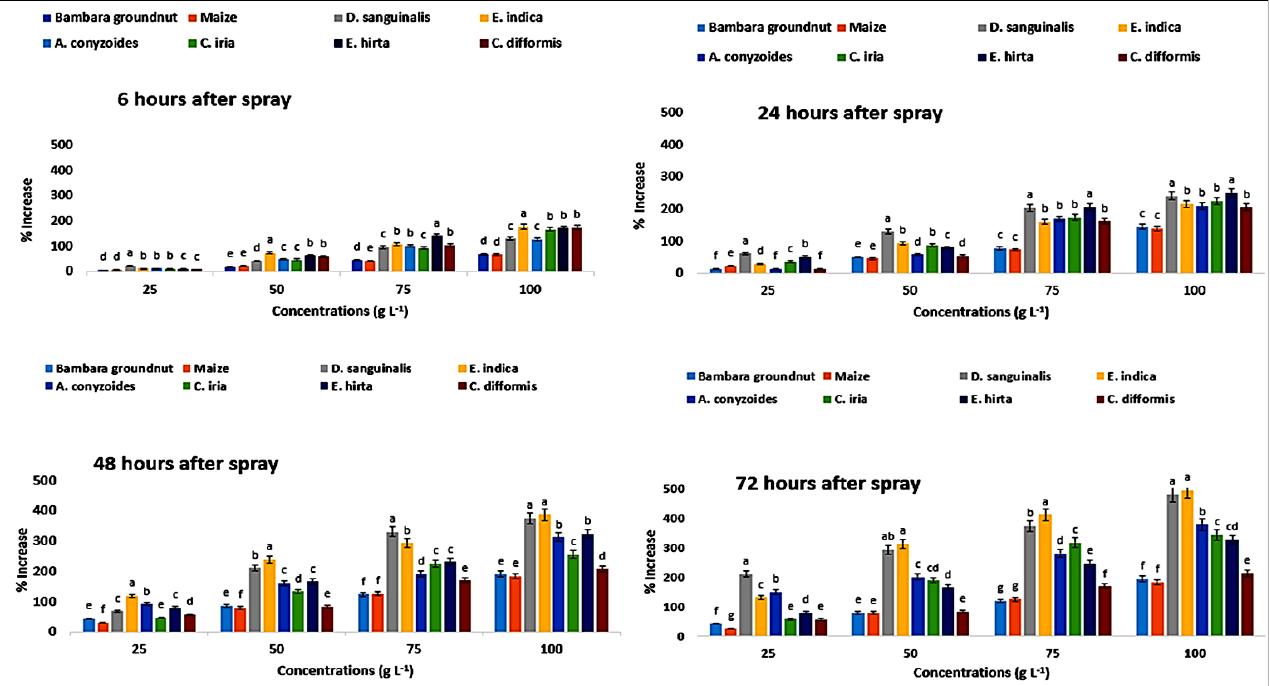
Figure 13. Increase (%) in proline content in test crops and weeds treated with leaf methanol extract of parthenium at the different associated times. Values with the same letter among the tested crops and weeds are not significantly different at the same extract concentrations at p ≤ 0.005, by Turkey’s HSD.